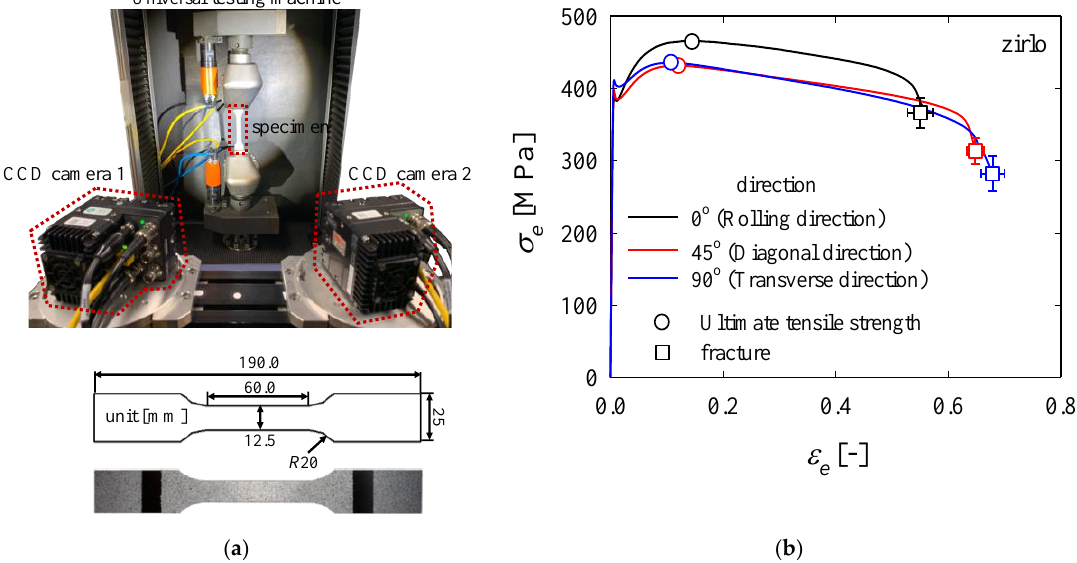
Figure 3. ( a ) Experimental setup and tensile test specimen. ( b ) Engineering stress vs. engineering strain curves with respect to the rolling direction (0°, 45°, and 90°).